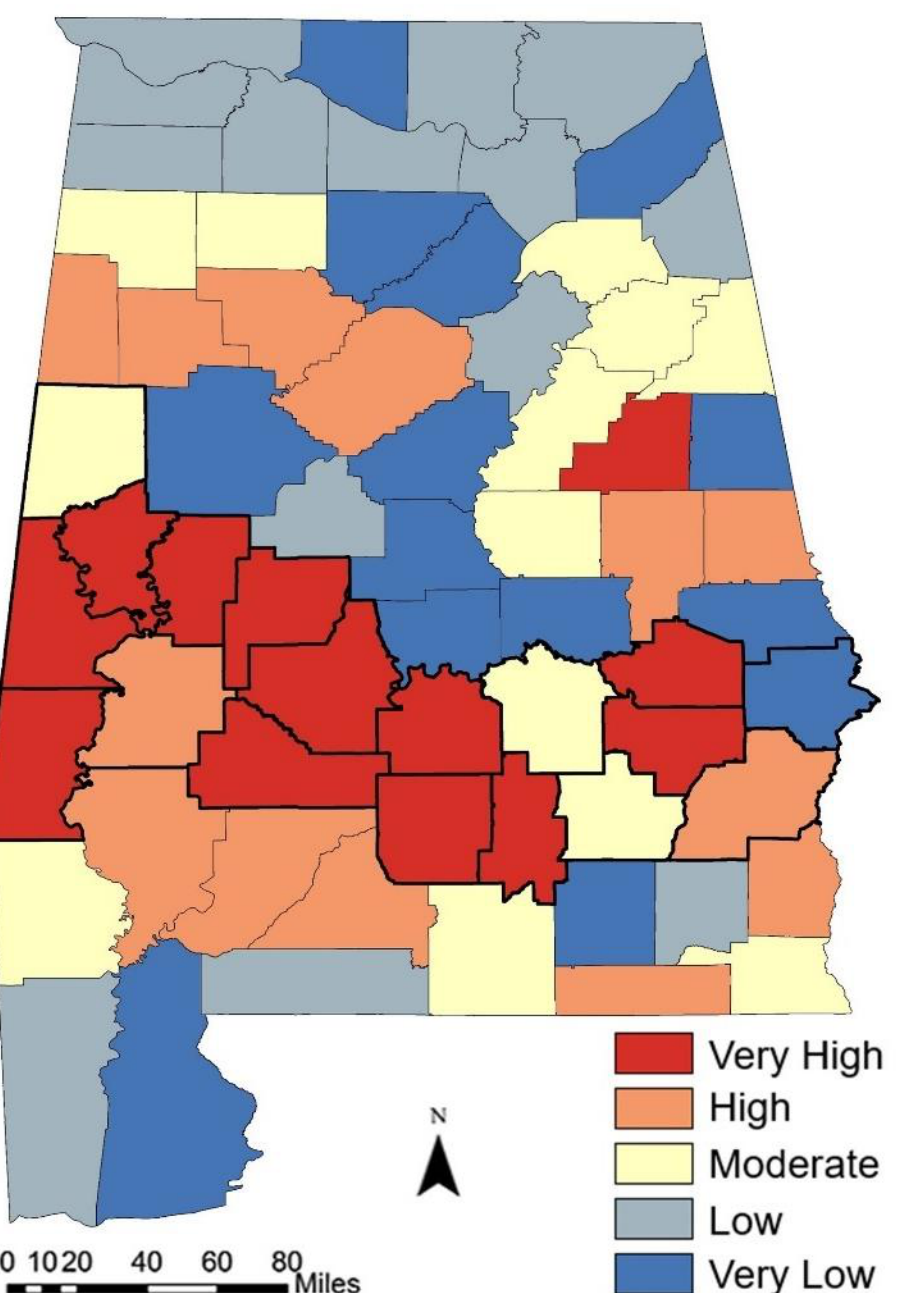
Figure 8. Spatial distribution of the overall COVID-19 Vulnerability Index at county level. The thick black lines indicate the boundaries of Black Belt counties.